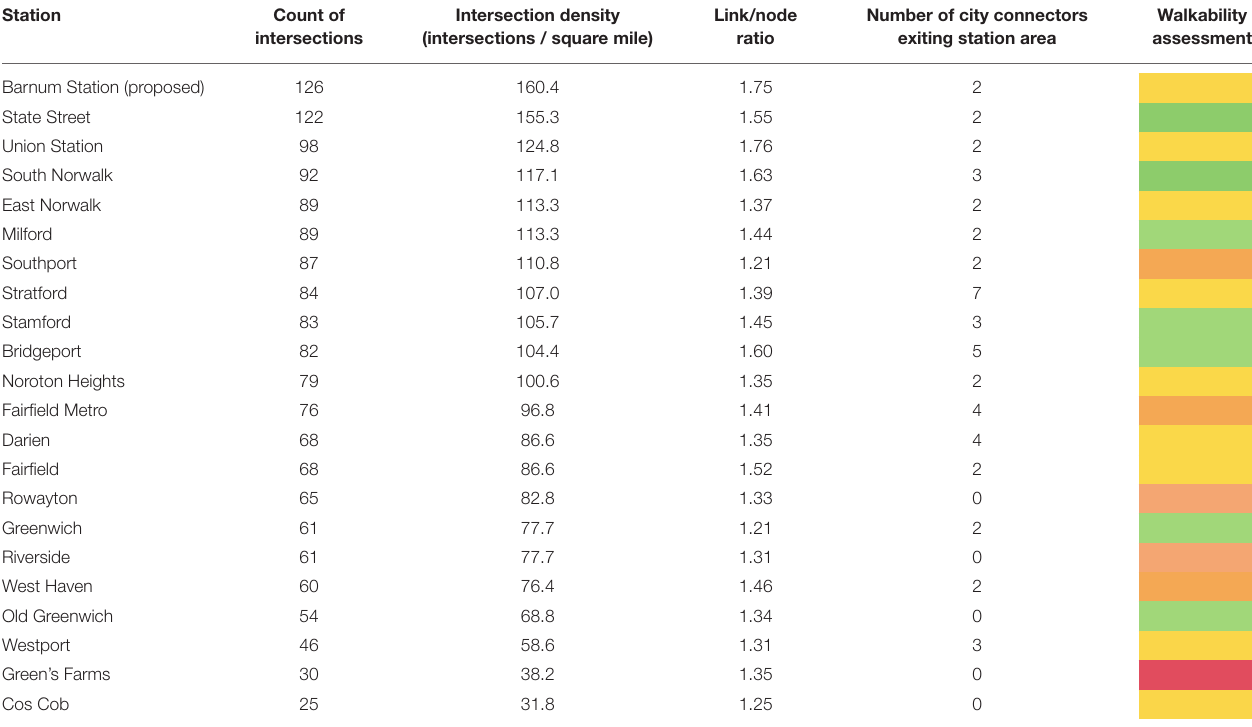
TABLE 3 | Street network analysis of Metro-North station areas.